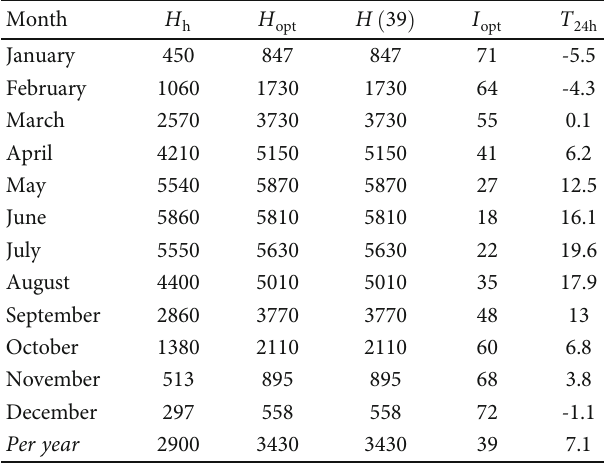
Table 2: Monthly solar activity on the roof of an o ffi ce